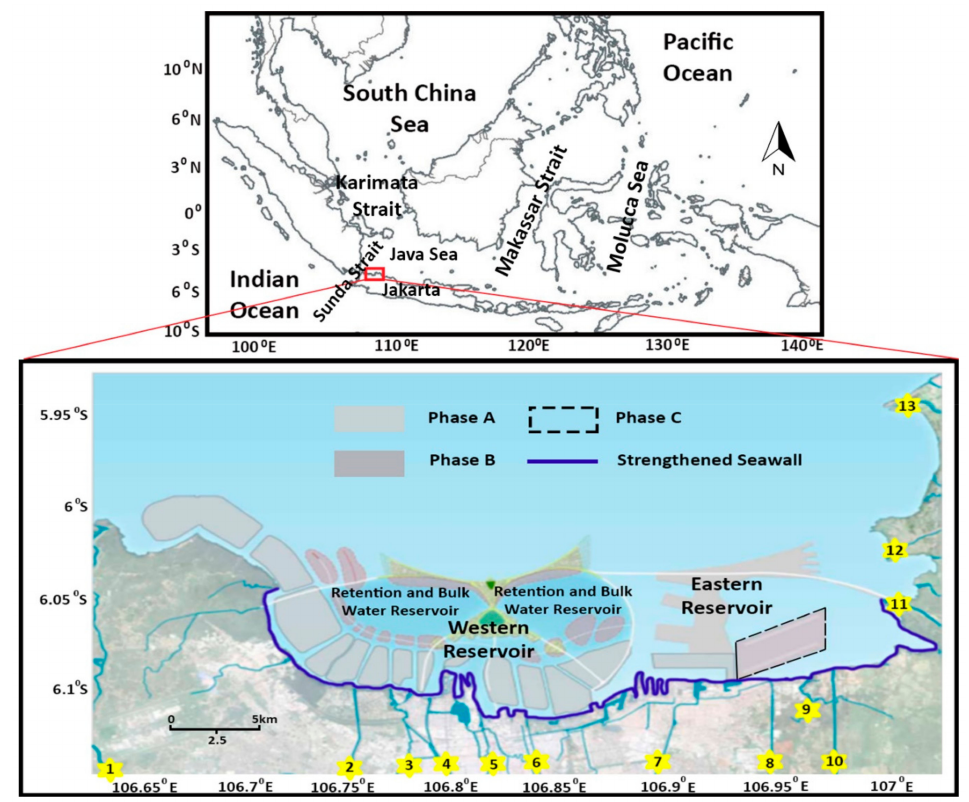
Figure 1. Map of the location of Jakarta Bay, and the Giant Seawall (GSW) as described in the NCICD Master Plan (Source: Master Plan NCICD). Numbers 1 to 13 correspond to